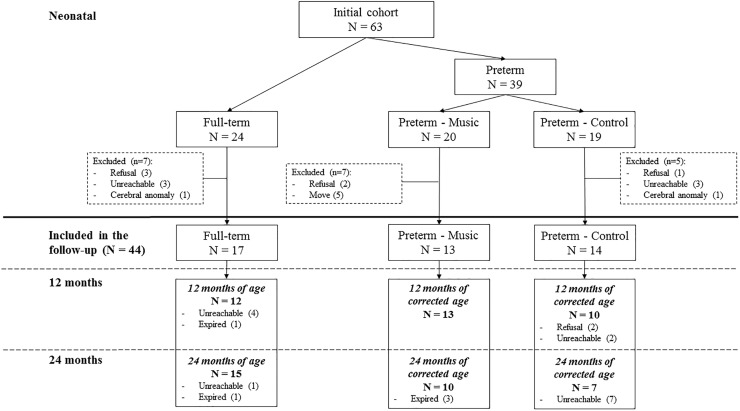
Flow chart of participants in the study.